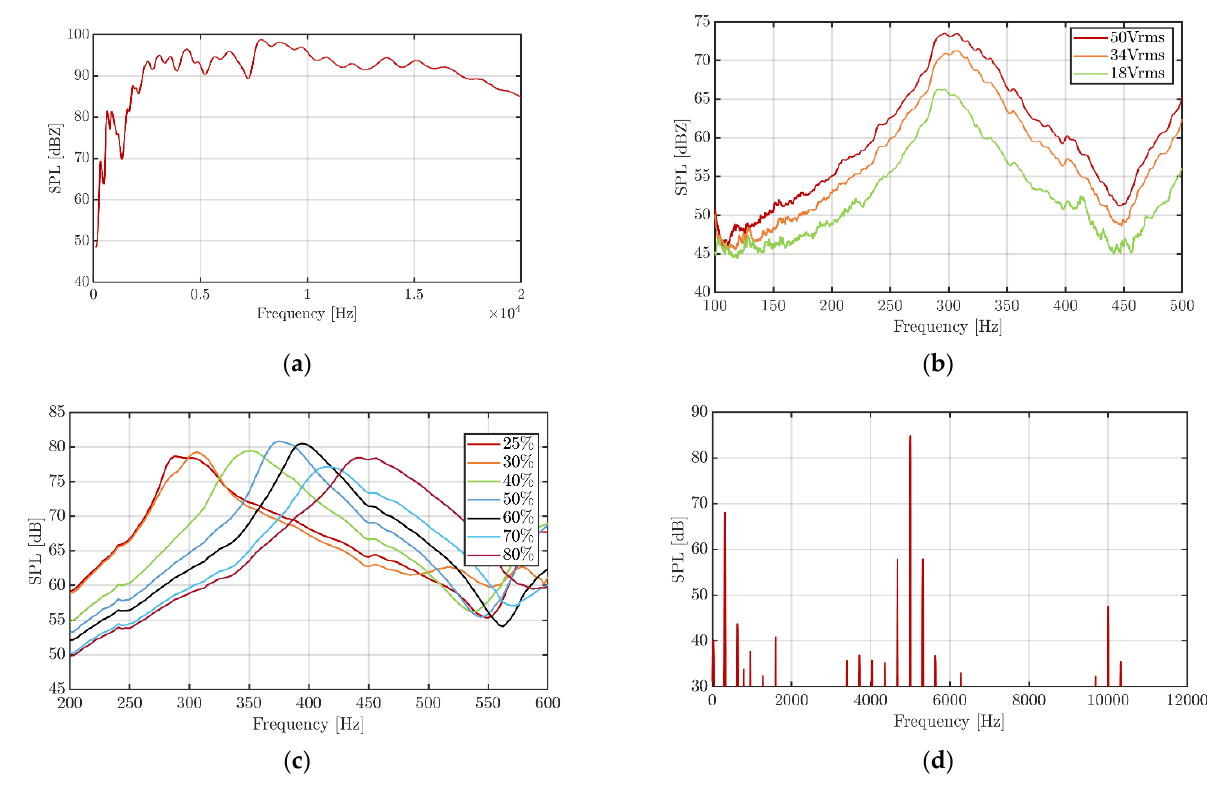
Figure 10. Acoustic performance of the printed multilayer transducer: ( a ) Frequency response for the full audio range from 100 Hz to 20 kHz; ( b ) Voltage and ;( c ) humidity dependency of the SPL for the haptic feedback relevant frequency range; ( d ) Frequency spectrum of the SPL for an applied bitonal sinusoidal signal combining 320 Hz and five kilohertz.